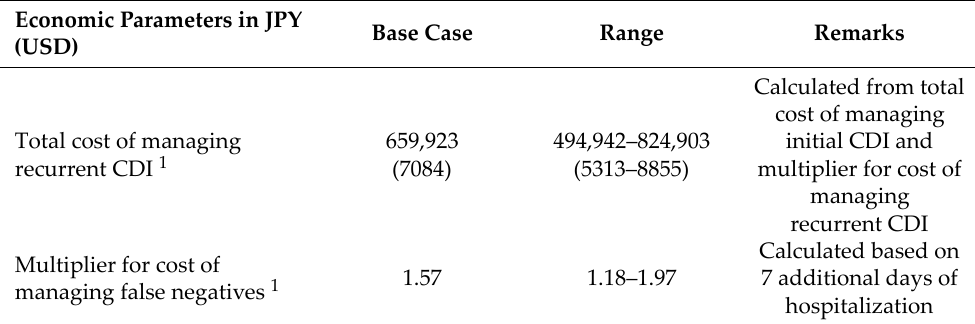
Table 2. Calculated economic parameters of the budget impact analysis.